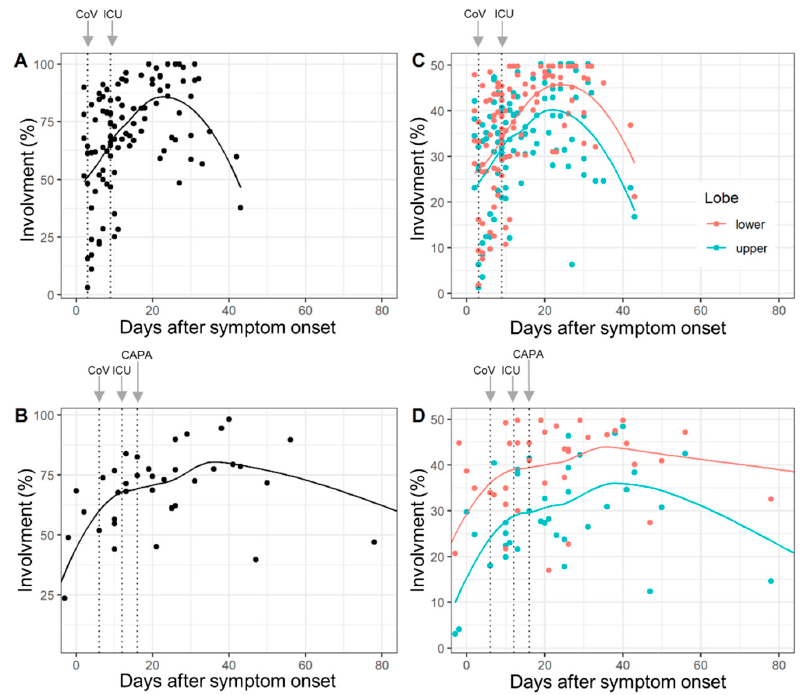
Figure 1. Total lung involvement ( A , B ) and lobe-wise involvement ( C , D ) (upper lobe: green line, lower lobe: red line) by days after COVID-19 symptom onset in COVID-19 patients ( A , C ) and COVID-19-associated pulmonary aspergillosis (CAPA) patients ( B , D ). Dots show % of affected tissue of individual CTs and the curved lines represent the locally estimated scatterplot smoothing (loess) regression line. The dotted vertical lines (left to right) illustrate median days until detection of SARS-CoV-2 (CoV), ICU admission (ICU) and CAPA diagnosis (CAPA). Chronological changes in the abnormal extent of CT did not differ between COVID-19 and CAPA patients ( p = 0.29) for interactions.